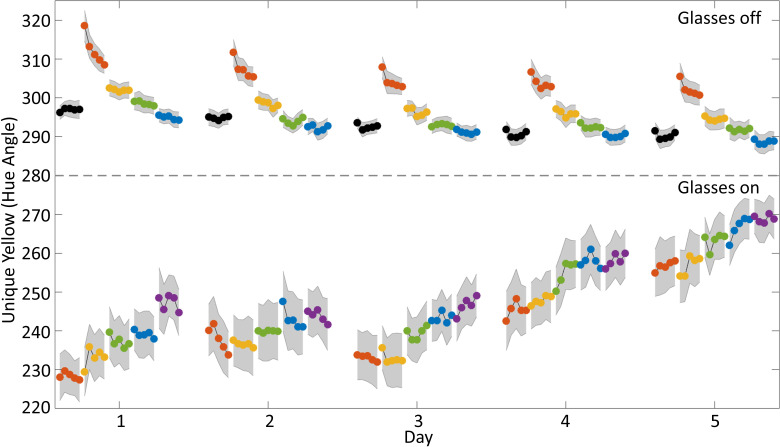
Block-by-block results.Morning and afternoon sessions within a day were averaged. The upper section of the figure shows unique yellow settings made with the glasses off. The black dots are baseline settings made immediately before putting on the glasses. The lower section of the figure shows unique yellow settings made with glasses on. Each dot in this figure represents the mean setting of a 1-min block, and five connected dots show the five blocks of each test. The first matches from tests two to five with glasses on in each session were influenced by the transition to the test display after breaks, and so were excluded when calculating the means. This did not affect the overall pattern of the results. Note that there were different amounts of time between the tests (See Figure 1C), during which observers were viewing uncontrolled stimuli, so one cannot simply connect the lines to get accurate adaptation and deadaptation time courses.